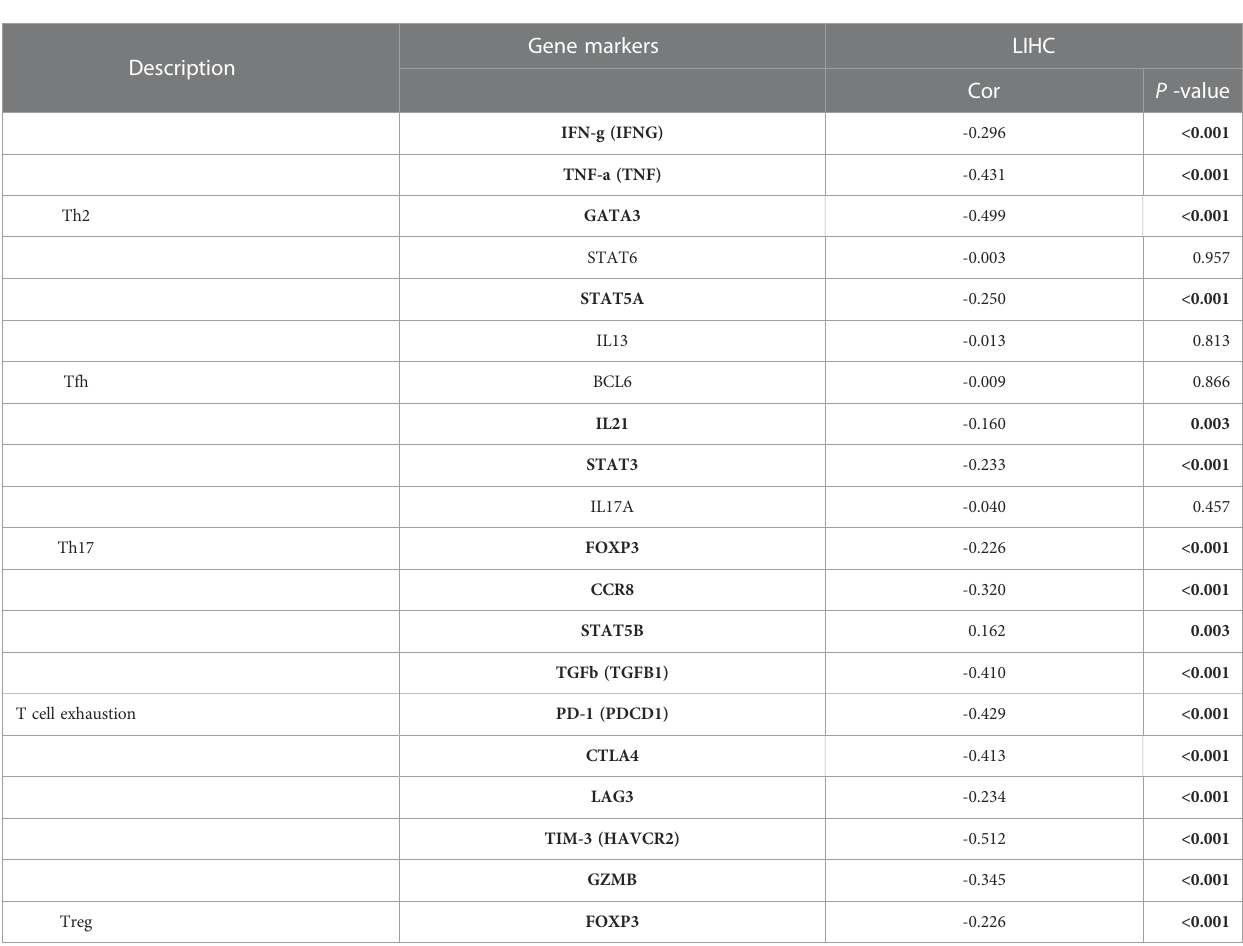
The bold values indicates that the correlation analysis between RAB22A and biomarker of immune cell is statistically signi fi